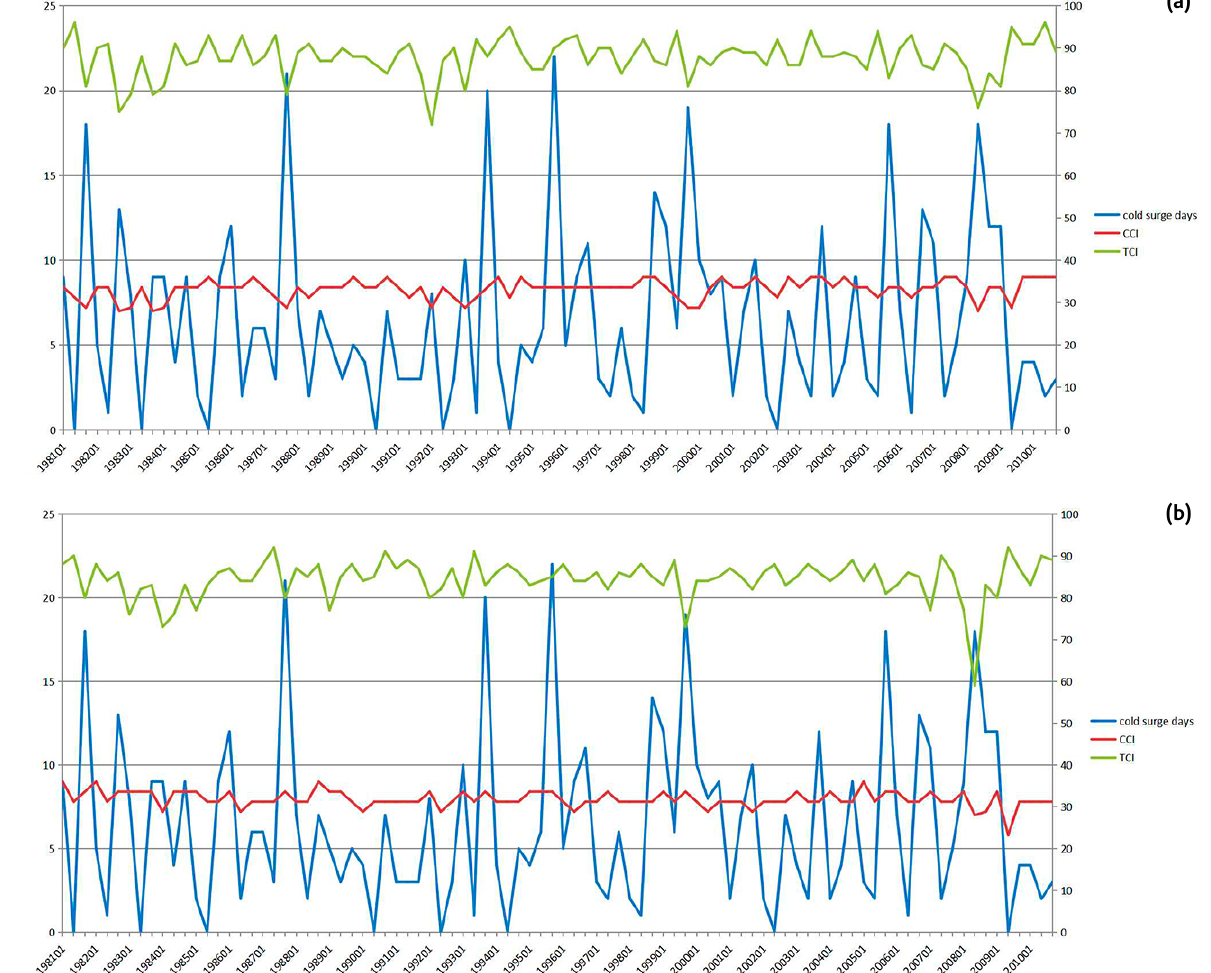
Figure 6. Monthly changes in the CCI (left vertical axis; red line) and TCI (right vertical axis; green line) relative to the incidence of cold surge days (left vertical axis; blue line) in winter for the period 1981–2010. Panel (a) corresponds to Yuanjiang in Yunnan; panel (b) depicts Hainan